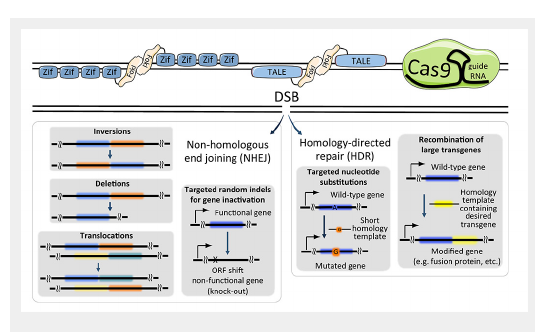
Comparisons of programmable nucleases and possible outcomes. Zinc finger nucleases (top left), transcription activator- like effector nucleases (TALENs; top middle) and CRIPSR/Cas9 (top right) systems introduce a site-directed double strand break (DSB) in DNA. Depending on the repair mechanism, nonhomologous end joining (NHEJ) or homology-directed repair (HDR), the site of interest can be left with random mutations, designed mutations, insertion of large transgenes, or (in case more than one DSB is generated), inversions, deletions and